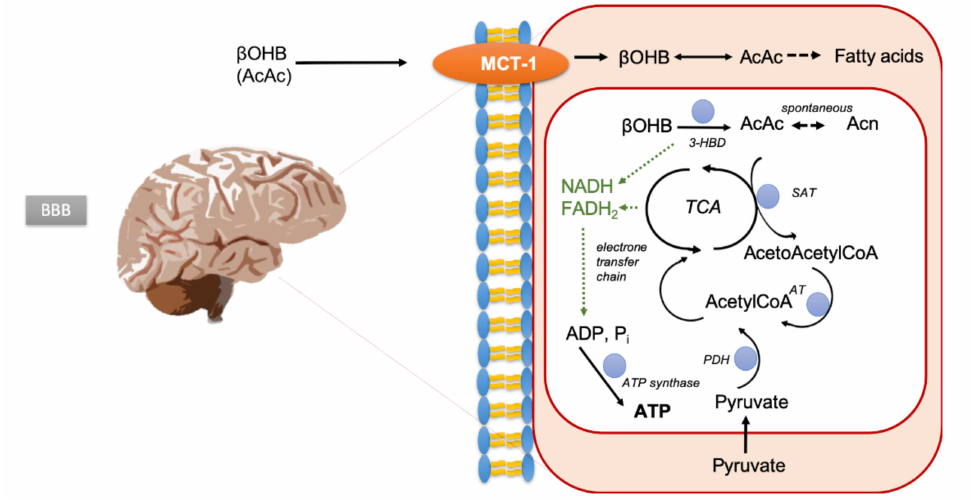
Figure 1. Brain uptake and metabolism of ketone bodies. 3-HBD, hydroxybutyrate dehydrogenase; SAT,